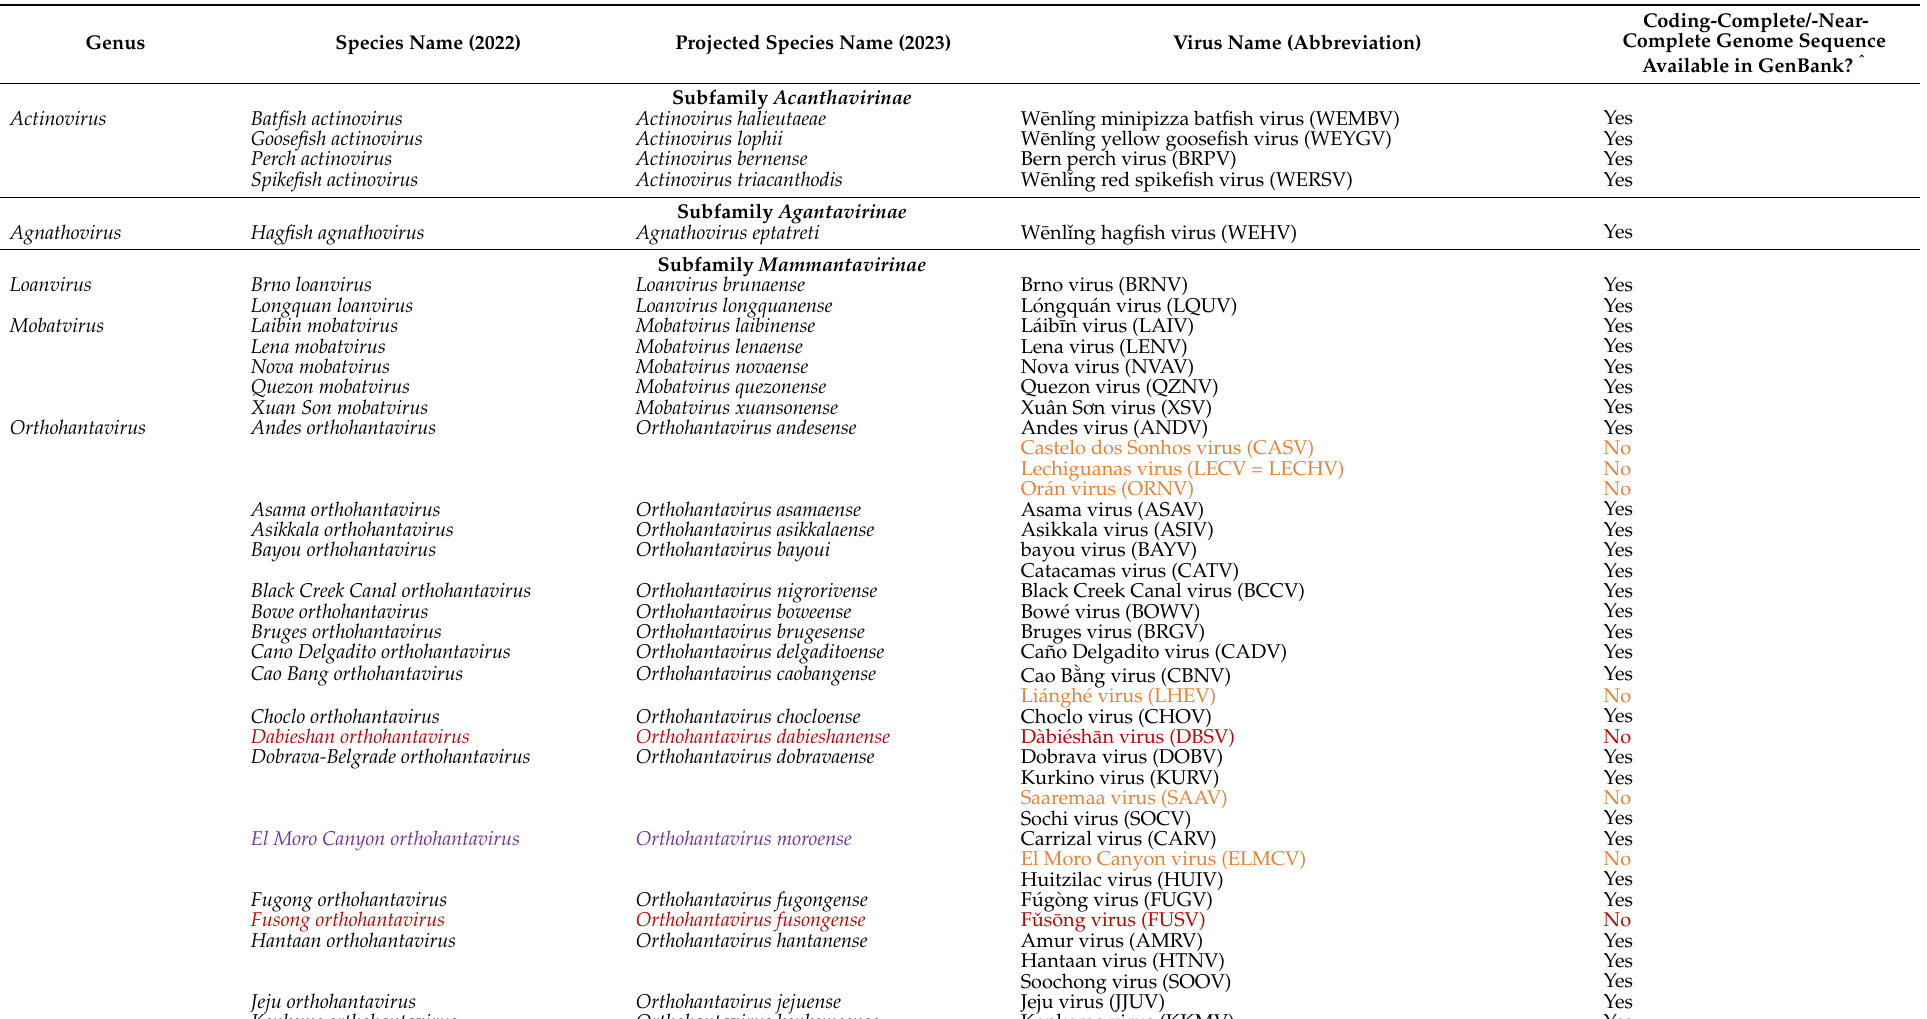
Table 1. Scheme of the 2022 [20] and projected 2023 [25] % taxonomy of the bunyaviral family Hantaviridae